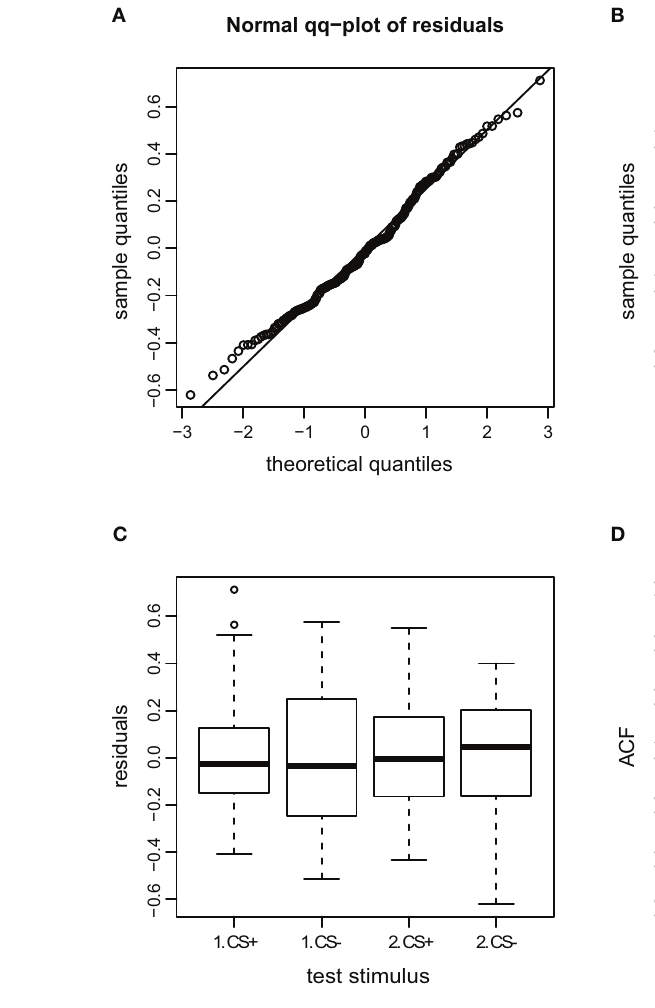
bees in the escape subset follows a normal distribution. (C) Boxplot of residuals of the AI for the test trials from the escape subset indicates that the residuals within each testing group are symmetrically distributed around the predicted means (which are aligned to y = 0). Variance of the residuals seems to be lower for the CS + than the CS − stimuli (especially for the first trial), indicating that AI in escaping bees varied less for the first CS + stimulus than for the remaining stimuli. (D) Autocorrelation plot of the deviance residuals (first bar indicating the residual correlated with itself). The following bars each indicate correlation to the previous